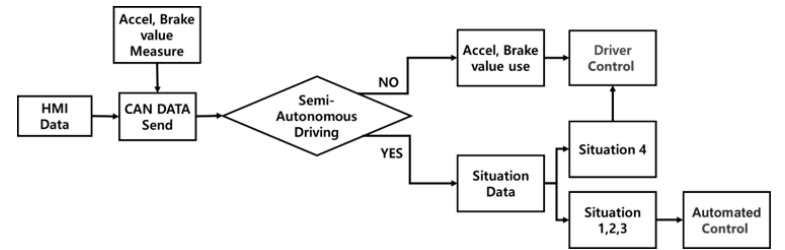
Figure 3. Semi-autonomous driving control flowchart.